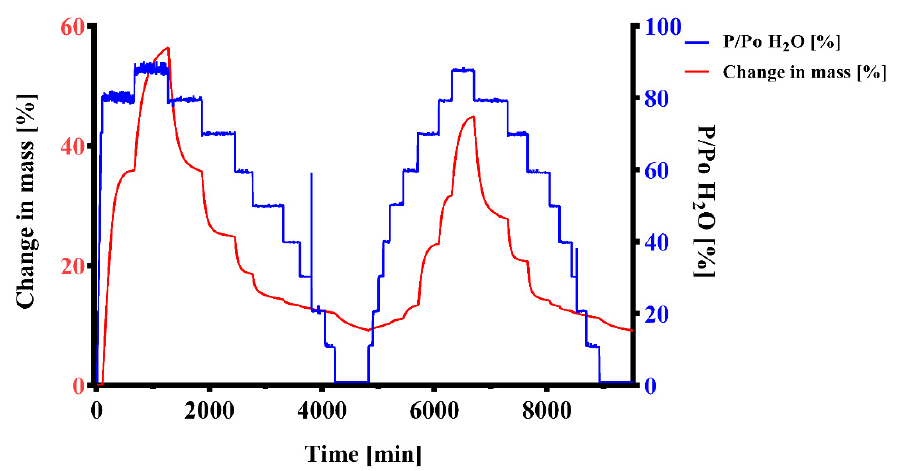
Figure 6. Dynamic vapor sorption change in mass analysis. An effervescent granule formulation containing mannitol as filler was investigated. Two cycles of absorption and desorption were performed, 0%-90%-0% P/P 0 in 10% stages. The change in mass was recorded over time. A mass change dm/dt = 0.002% min − 1 or 600 min (whichever occurred first) were selected as criteria for changing the humidity stage.